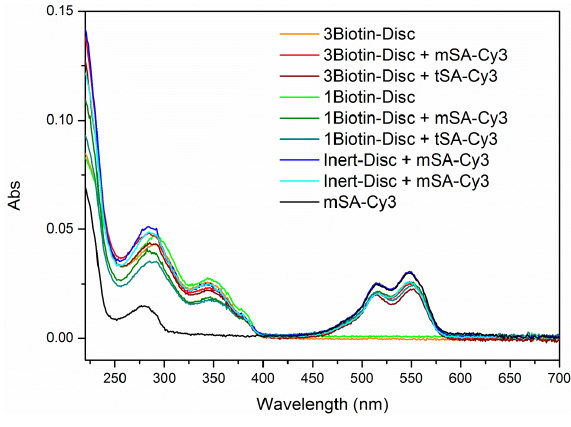
Figure 7. Absorption spectra after addition of 70 nM of corresponding protein during FRET